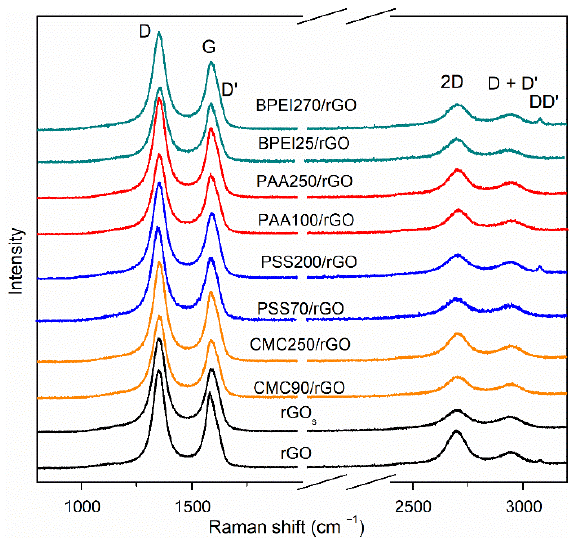
Figure 5. Raman spectra of rGO with PEs. For comparison, the spectra of pristine rGO and rGOs after sonication in water are also